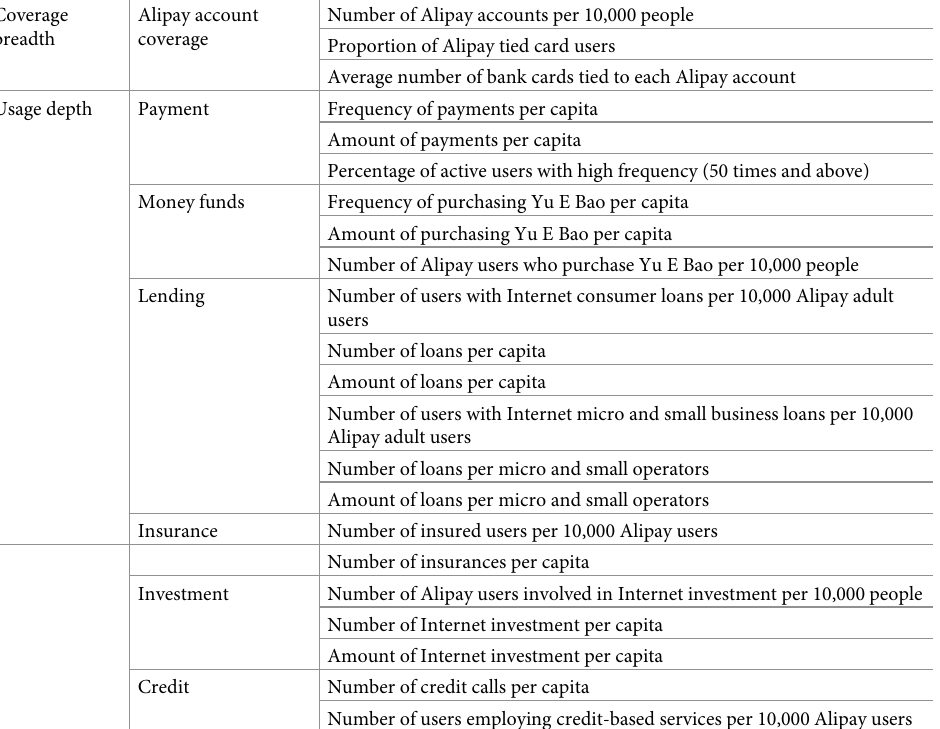
Table 1. The indicator system of digital